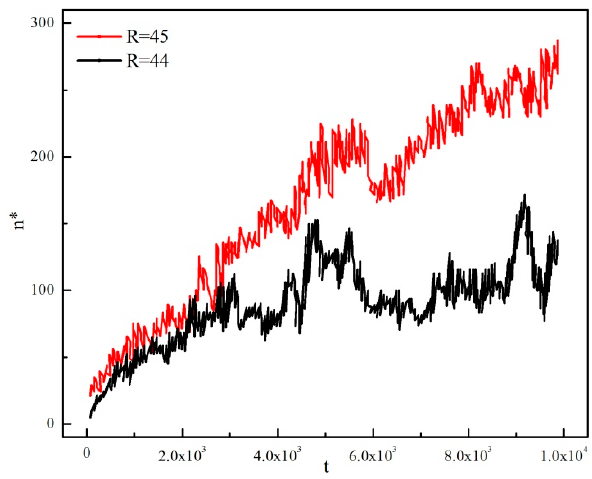
Figure 11. The order parameter η vs. R under the four routing strategies.